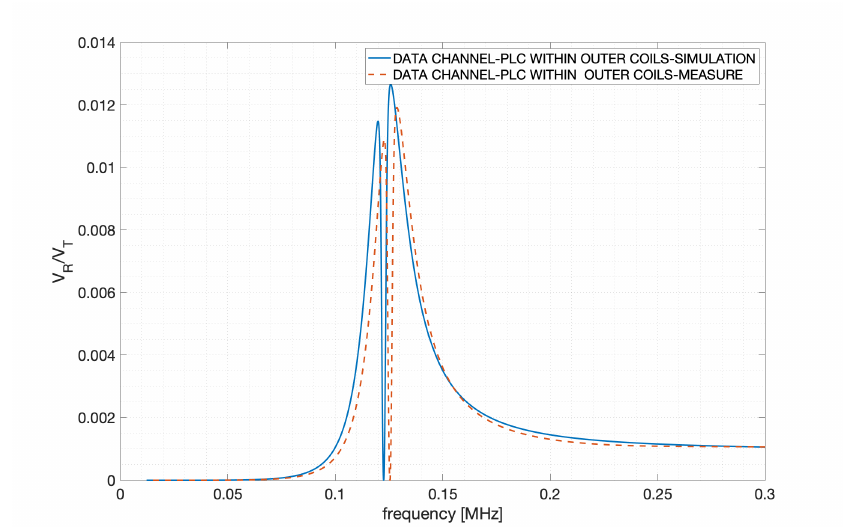
Figure 14. Transfer function comparison between measurement and calculations for the data channel, case 2a.